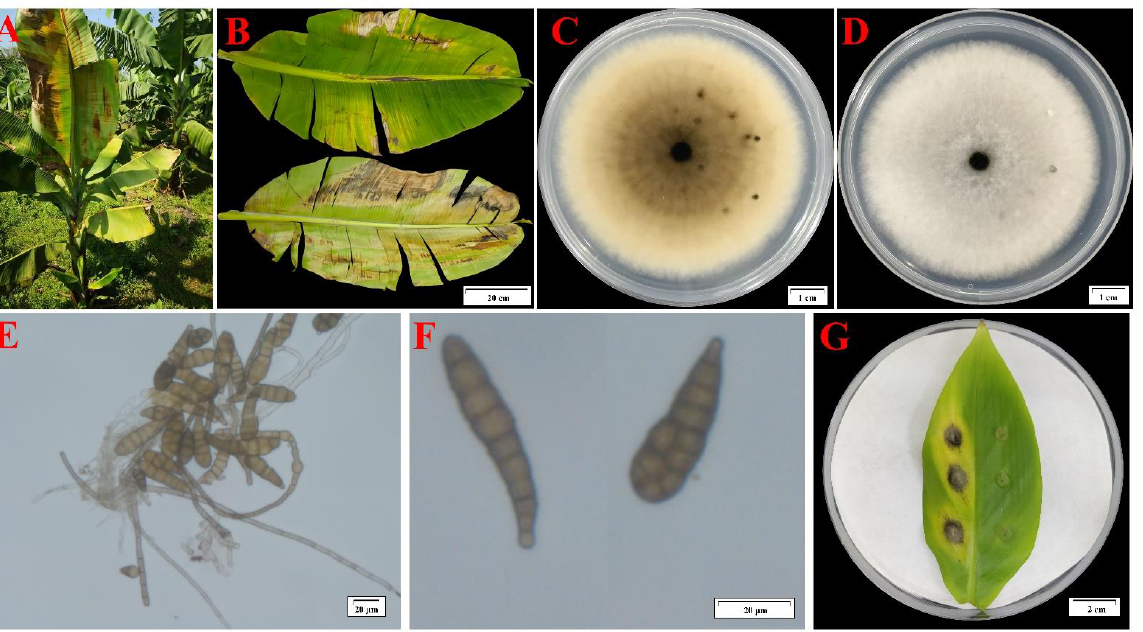
Figure 1. Leaf blight disease symptoms on banana and morphology of the causal pathogen. ( A ) Leaf blight disease symptoms in the field; ( B ) Leaf blight-diseased leaves; ( C , D ) Colonies of Alternaria jacinthicola on PDA (C, reverse; D, obverse); ( E , F ) Representative hyphae and conidia of A. jacinthicola ; ( G ) Leaf symptoms at 4 days after A. jacinthicola inoculation; the left leaf part was inoculated with A. jacinthicola agar discs and the other part was inoculated with PDA agar discs. To molecularly identify the fungal species, we performed PCR using internal tran- scribed spacer ( ITS ) universal primer pair ITS1/ITS4 [29], partial translation elongation factor 1- α ( TEF ) universal primer pair EF1-728F/EF1-986R [30], glyceraldehyde-3-phosphate dehy- drogenase ( GAPDH ) universal primer pair gpd1/gpd2 [31], and Alternaria major allergen ( Alt a1 ) specific primer pair Alt F/Alt R [32]. Sanger sequencing results showed that length of the corresponding PCR product for ITS , TEF , GAPDH , and Alt a1 gene was 565 bp, 280 bp, 577 bp, and 472 bp for strain L1, and 565 bp, 280 bp, 577 bp, and 468 bp for strain L2, respectively (Supplemental Figure S1). BLASTn search results showed that the ITS se- quences of strain L1 and L2 were both 100% identical to several Alternaria species (such as MN955461.1, MG012259.1, and MN822559.1). The TEF sequence of strain L1 was 100% identical to TEFs of A. jacinthicola (MK672904.1 and KY513872.1), A. burnsii (MW183801.1), and A. alternata (MF741188.1). The TEF sequence of strain L2 was 98 – 99% identical to TEFs of A. jacinthicola (MK672904.1), A. burnsii (MZ126803.1), and A. alternata (MF741188.1). The GAPDH sequences of strain L1 and L2 were the same, and shared 99% identity with the GAPDHs of A. jacinthicola (MK649888.1), A. burnsii (KY524274.1), and A. tomato (KP124294.1). The Alt a1 gene sequences of strain L1 and L2 were about 99% identical to the Alt a1 genes of A. jacinthicola (MG781013.1) and A. alternata (OK040812.1). To further determine the fungal pathogen causing leaf blight on Robusta banana, four phylogenetic trees were constructed using GAPDH , TEF , Alt a1 , and tandemly linked ITS - GAPDH - TEF - Alt a1 sequences of strain L1 and strain L2 and corresponding sequences from some other Alternaria species, respectively. A phylogenetic tree constructed based on GAPDH sequences showed that the relationship between the two strains and A. jacin- thicola isolate strain F217169 was the closest (Figure 2A). A phylogenetic tree constructed based on the TEF gene sequences showed that Strain L1 was closest to A. jacinthicola isolate strain F217169, but strain L2 was close to A. jacinthicola , A. alteranta and A. burnsii (strain F217169, 170242, and NCYU 19-0144) (Figure 2B). A phylogenetic tree constructed based